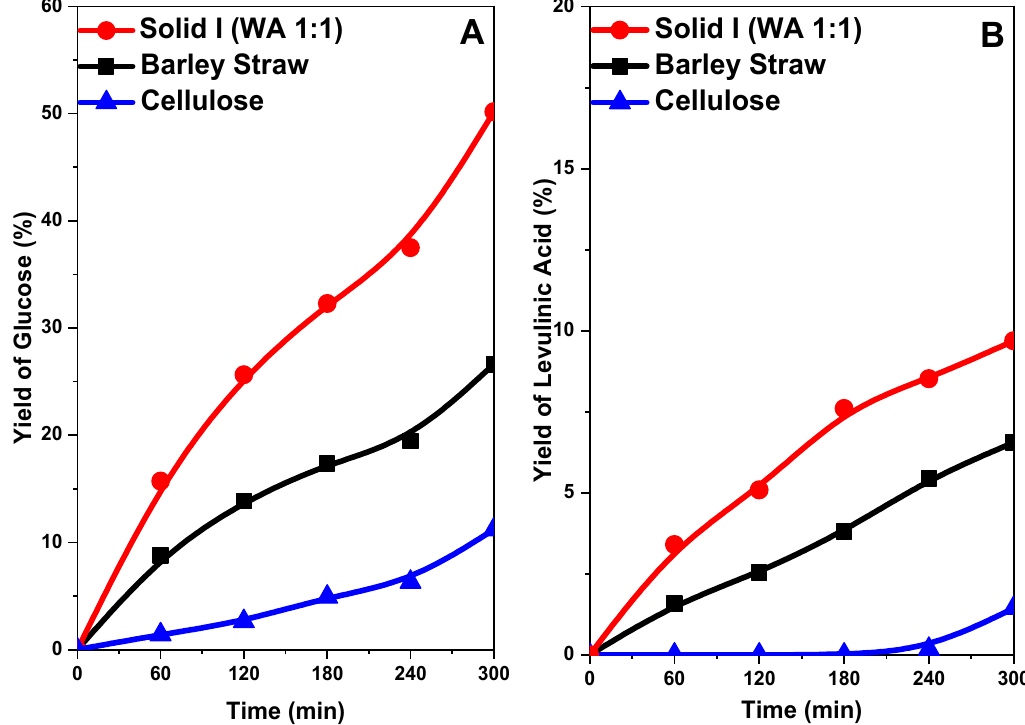
Figure 12. Yield of glucose ( A ) and levulinic acid ( B ) from the hydrolysis of cellulose, untreated barley straw and barley straw treated (Solid I) with [EMIMAcO].